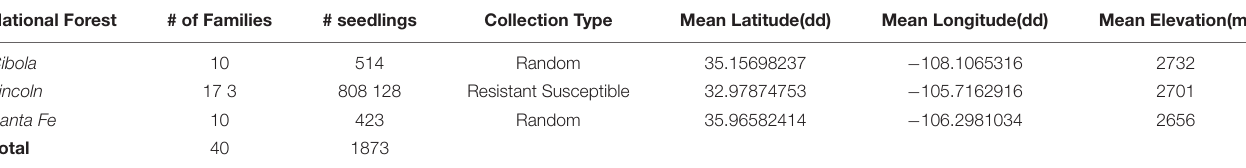
TABLE 1 | Forty parent trees were selected from three national